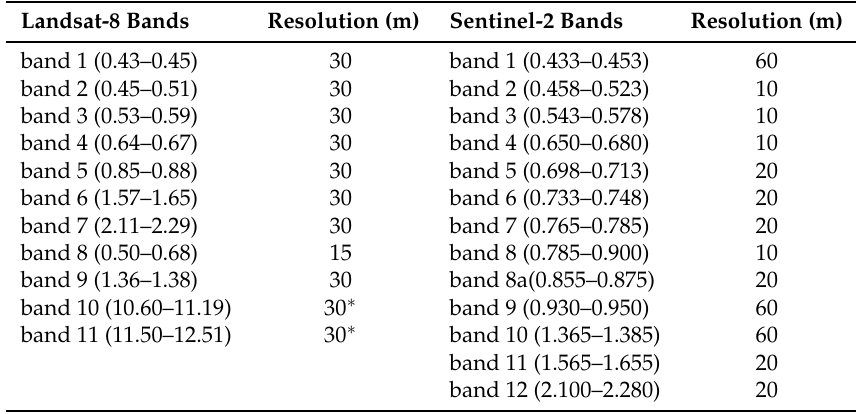
Table 1. Landsat-8 and Sentinel-2 spectral bands and spatial resolution (L8 bands 10, 11: 100 m resolution resampled to 30 m in the L1T product, marked with ’*’ in